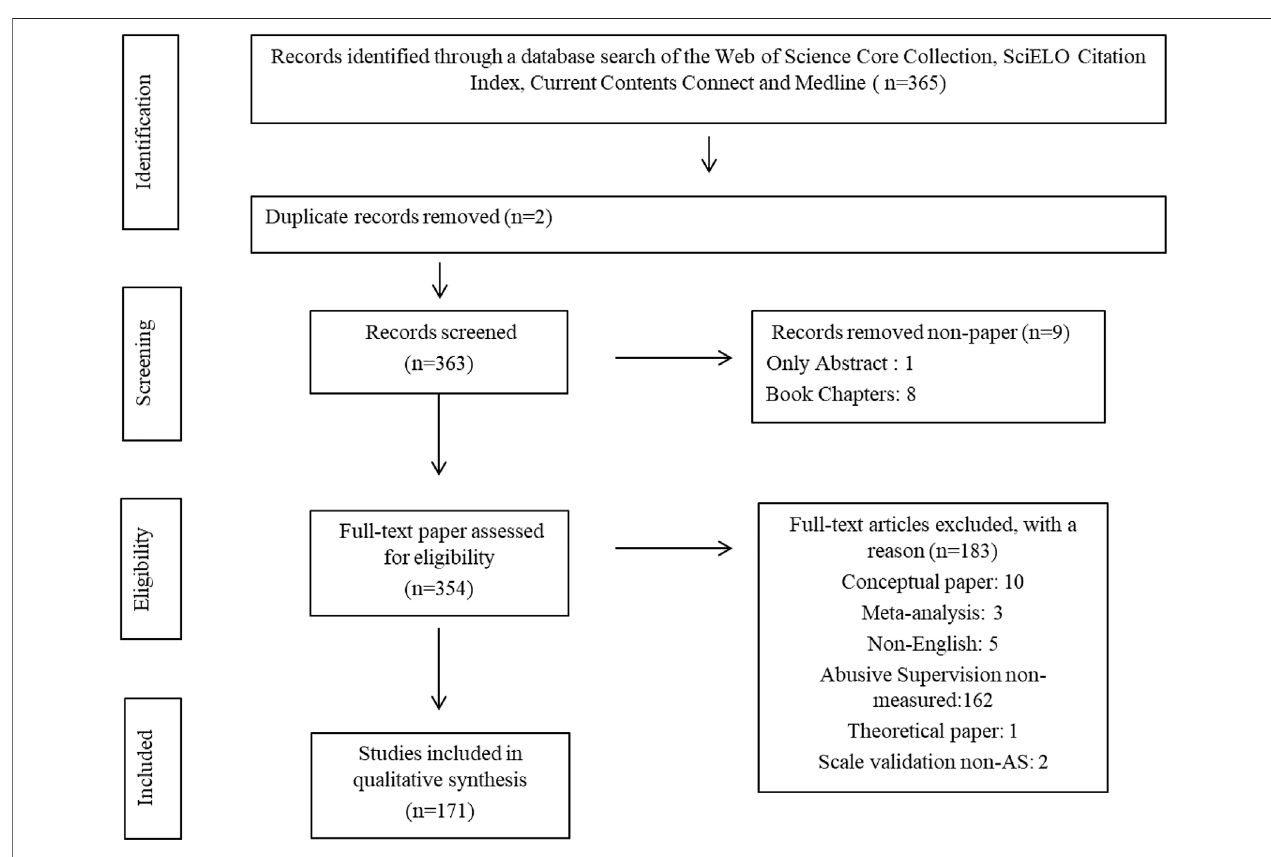
FIGURE 1 | PRISMA fl ow diagram of the applied paper selection process.